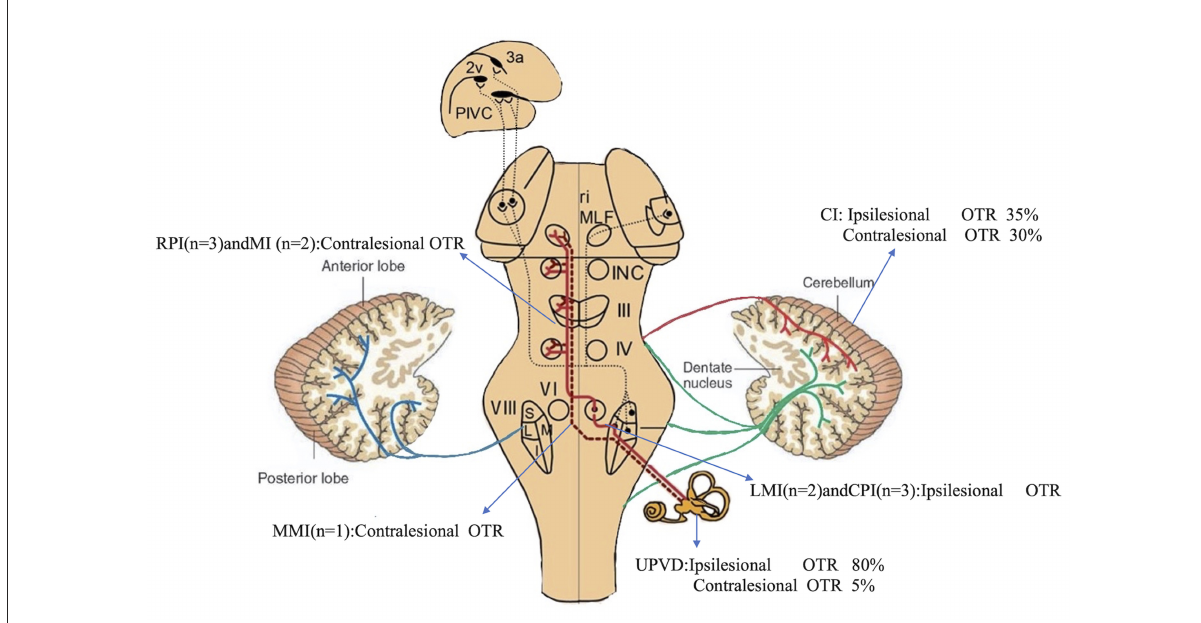
FIGURE2 Incidence and direction of pathological OTR caused by different structural injuries. Pathways from the utricles and vertical semicircular canals mediate graviceptive function in the frontal roll plane. These pathways ascend from the vestibular nuclei (VIII) to the ocular motor nuclei, including the trochlear nucleus (IV), oculomotor nucleus (III), and abducens nucleus (VI). From here, they travel to the supranuclear centers of the interstitial nucleus of Cajal (INC), and the rostral interstitial nucleus of the medial longitudinal fasciculus (riMLF) in the midbrain tegmentum. RPI, rostral pontine infarction; CPI, caudal pontine infarction; MI, midbrain infarction; blue line, vestibulocerebellar fibers; green line, reticulocerebellar fibers; red line, pontocerebellar fibers [modified from Dieterich and Brandt (19)].